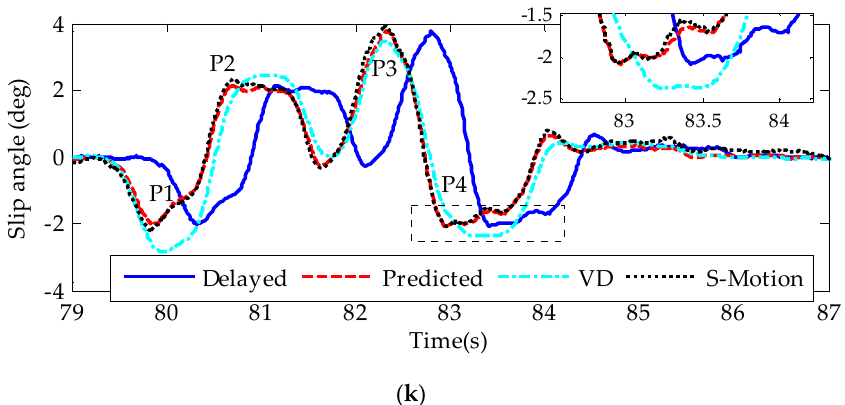
Figure 10. Test results in double lane change (DLC) maneuver: ( a ) trajectory; ( b ) acceleration; ( c ) angular speed; ( d ) steering wheel angle; ( e ) steering wheel angular speed; ( f ) roll angle; ( g ) partial enlarged detail of roll angle; ( h ) pitch angle; ( i ) flat; ( j ) longitudinal velocity; ( k ) slip angle.